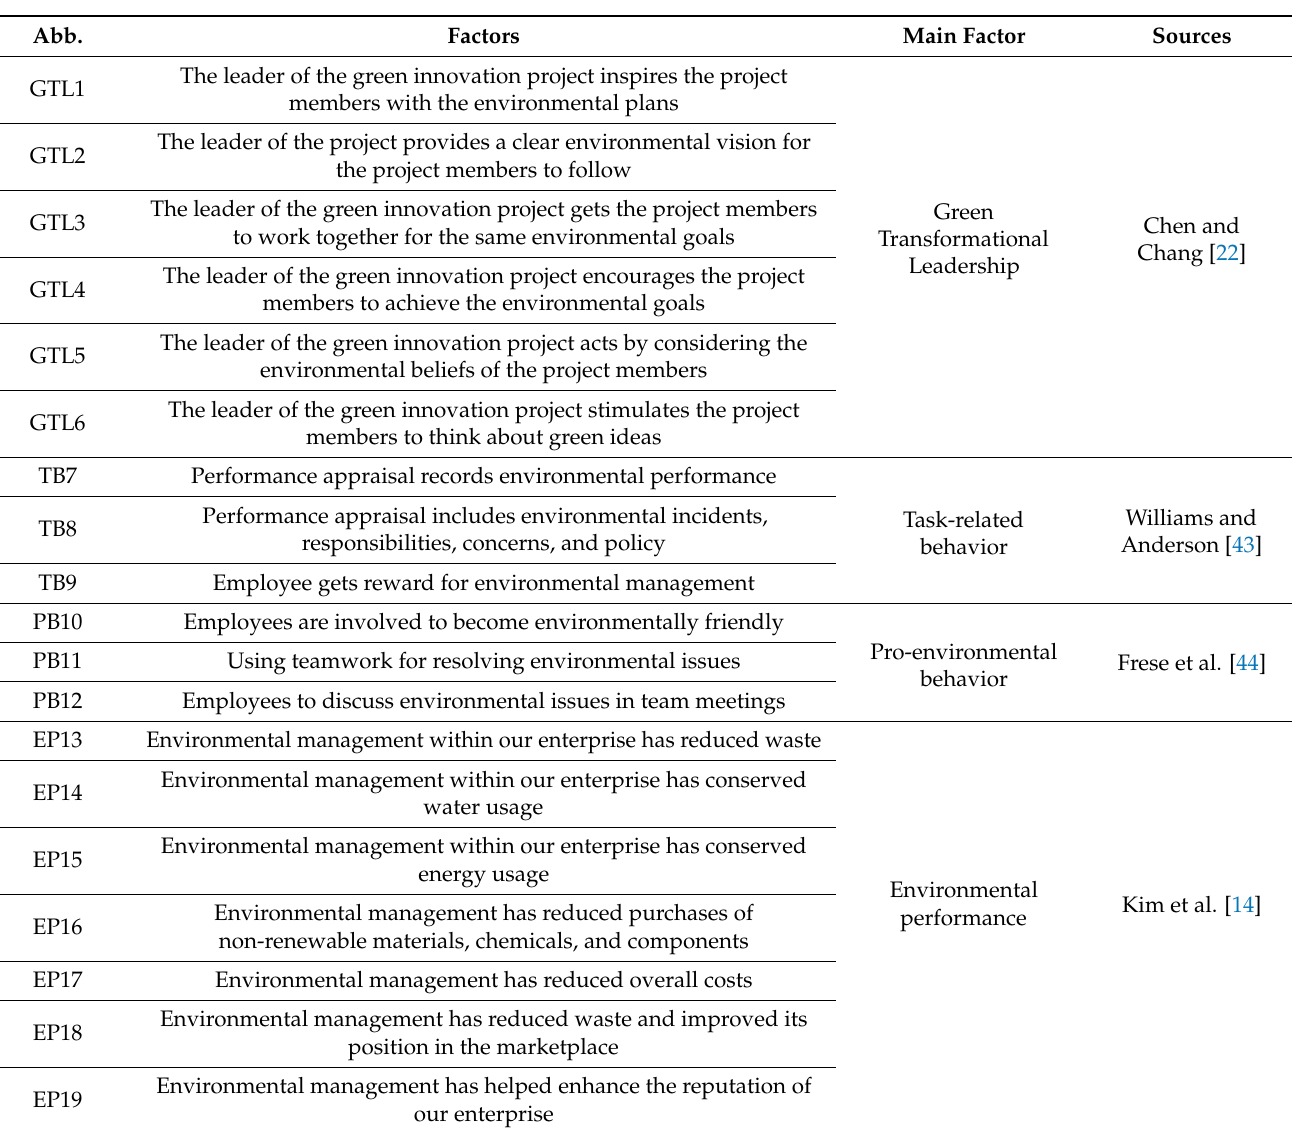
Table 1. The factors in the